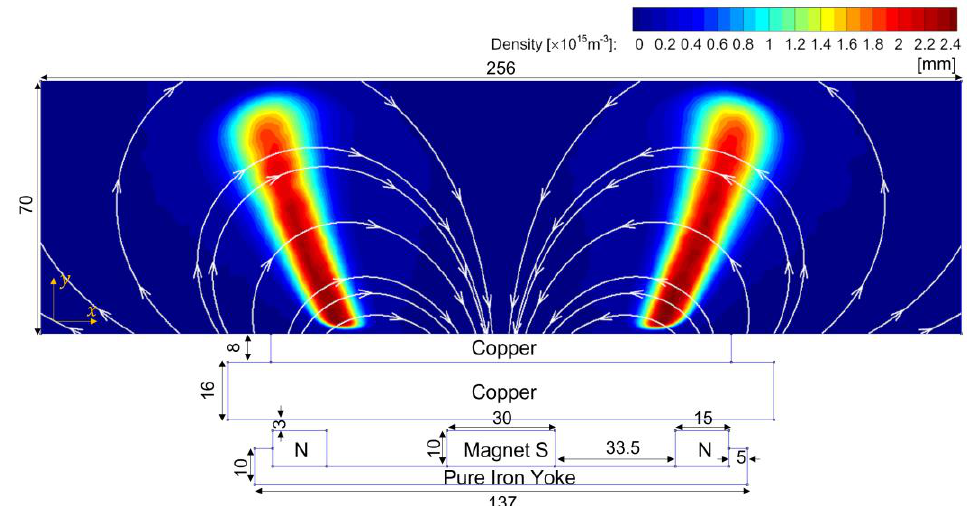
Figure 1. A schematic domain of the two-dimensional simulation with the plasma density and magnetic field lines. The length scale is in mm.